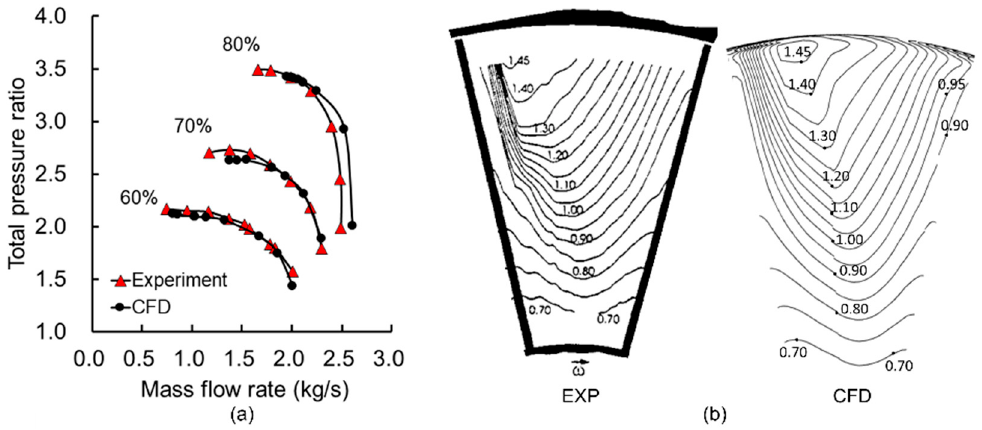
Figure 8. Comparison of ( a ) pressure ratio and ( b ) relative Mach number near the inlet of SRV2-O. EXP: experiments.